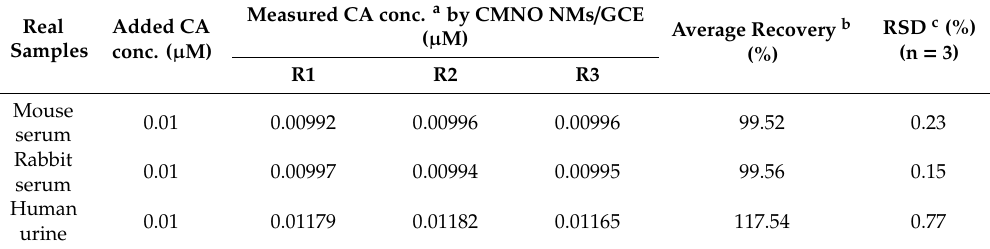
Table2. AnalysesofrealbiologicalsampleswithCMNONMs / GCEsensorprobebyelectrochemicalmethod. Real Added CA Samples conc. ( µ